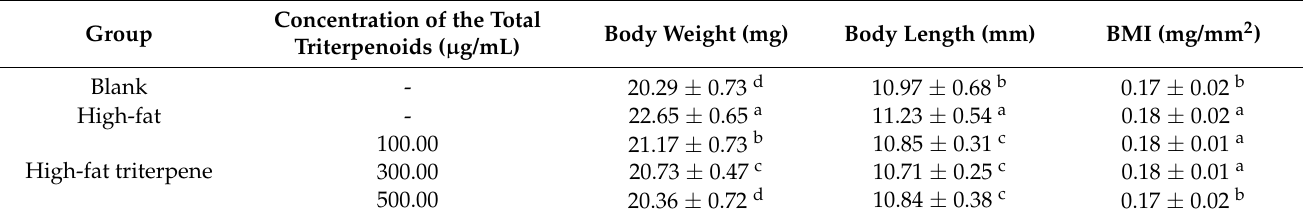
Table 3. The results for the